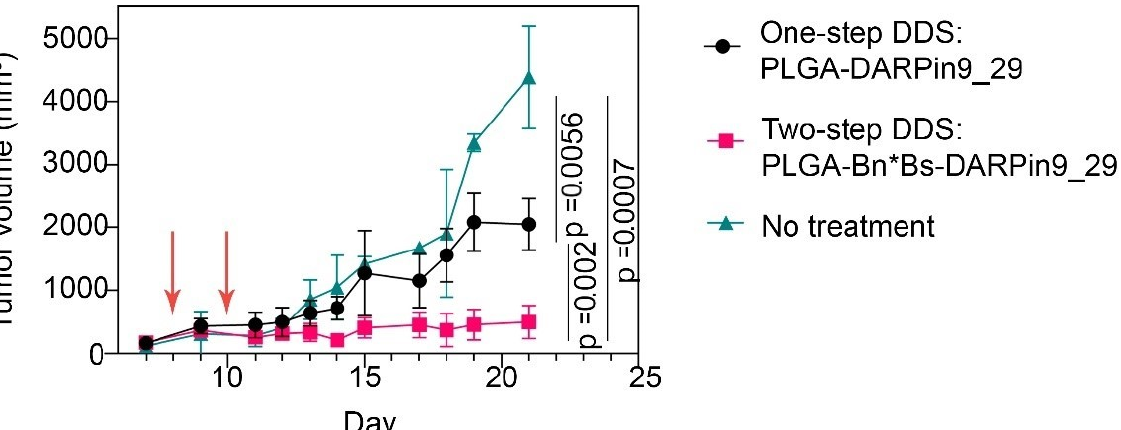
Figure 6. EMT-HER2 tumor growth dynamics under the treatment with one-step DDS, PLGA*DARPin9_29 particles, or two-step DDS, Bs-DARPin9_29 and PLGA-Bn (n = three mice for each group). Red arrows indicate the nanoagent injections.